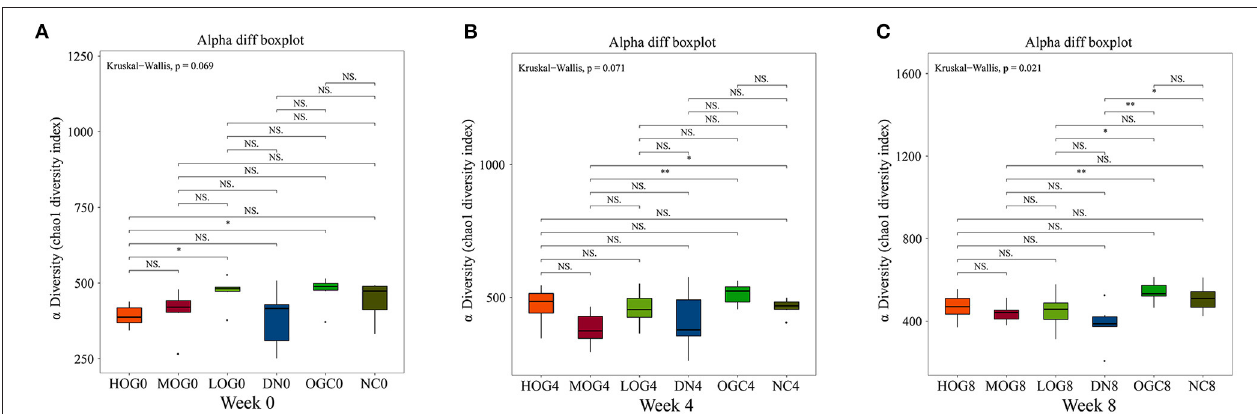
FIGURE 3 | Chao1 index of gut microbiota at 0 (A) , 4 (B) , and 8 (C) weeks. Chao1 index was used to estimate the total number of species in samples: larger Chao1 values indicate more species.